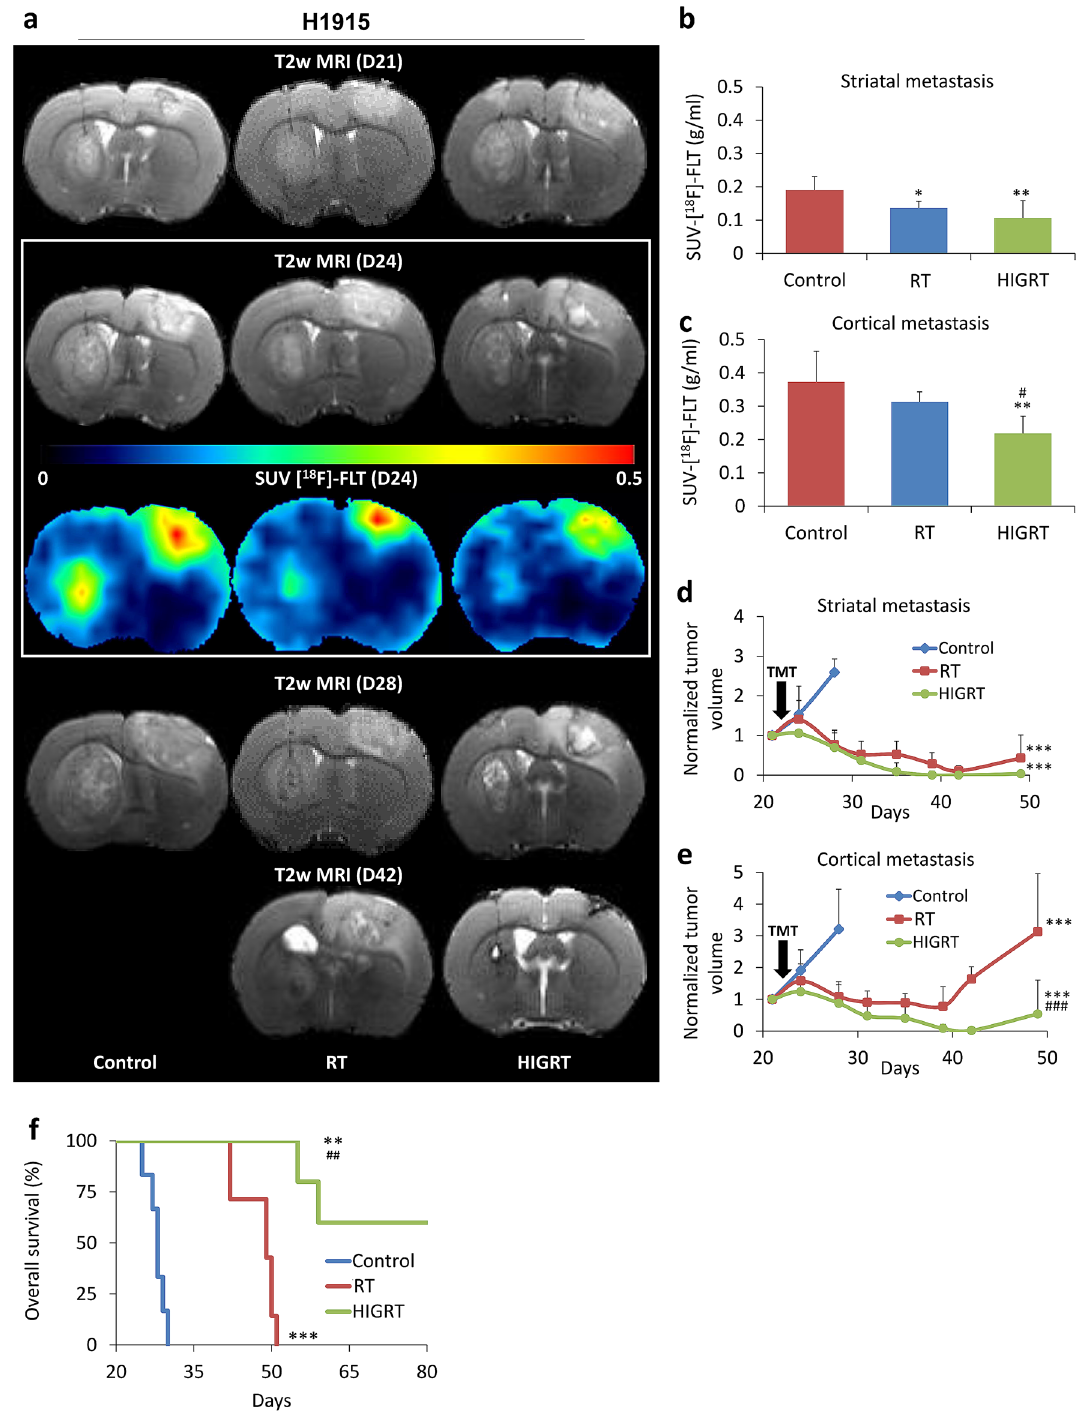
Figure 7. Treatment effect on tumor volumes, cell proliferation and overall survival. ( a ) Representative T2w- MRI and [ 18 F]-FLT images for the three different groups of rats before and after treatments. From the top to the bottom: T2w-MRI before treatment (D21); T2w-MRI one day after treatments (D24); [ 18 F]-FLT images at D24 and lastly, T2w-MRI at D28 and D42. Quantitative analyzes of SUV-[ 18 F]-FLT one day after treatments in ( b ) striatal metastases and ( c ) cortical metastases. Mean ± SD, n = 7 for Control and RT groups and n = 6 for HIGRT group, * p < 0.05 and ** p < 0.01 versus Control group and # p < 0.05 versus RT group. Quantitative analyzes of tumor volume before and after treatment in ( d ) striatal metastases and ( e ) cortical metastases (TMT: treatments). Mean ± SD, n = 7 for Control and RT groups and n = 6 for HIGRT group, *** p < 0.001 versus Control group and ### p < 0.001 versus RT group. ( f ) Kaplan–Meier curves of survival, n = 6 for Control, n = 7 for RT and n = 5 for HIGRT groups. ** p < 0.01 and *** p < 0.001 versus Control group and ## p < 0.01 versus RT